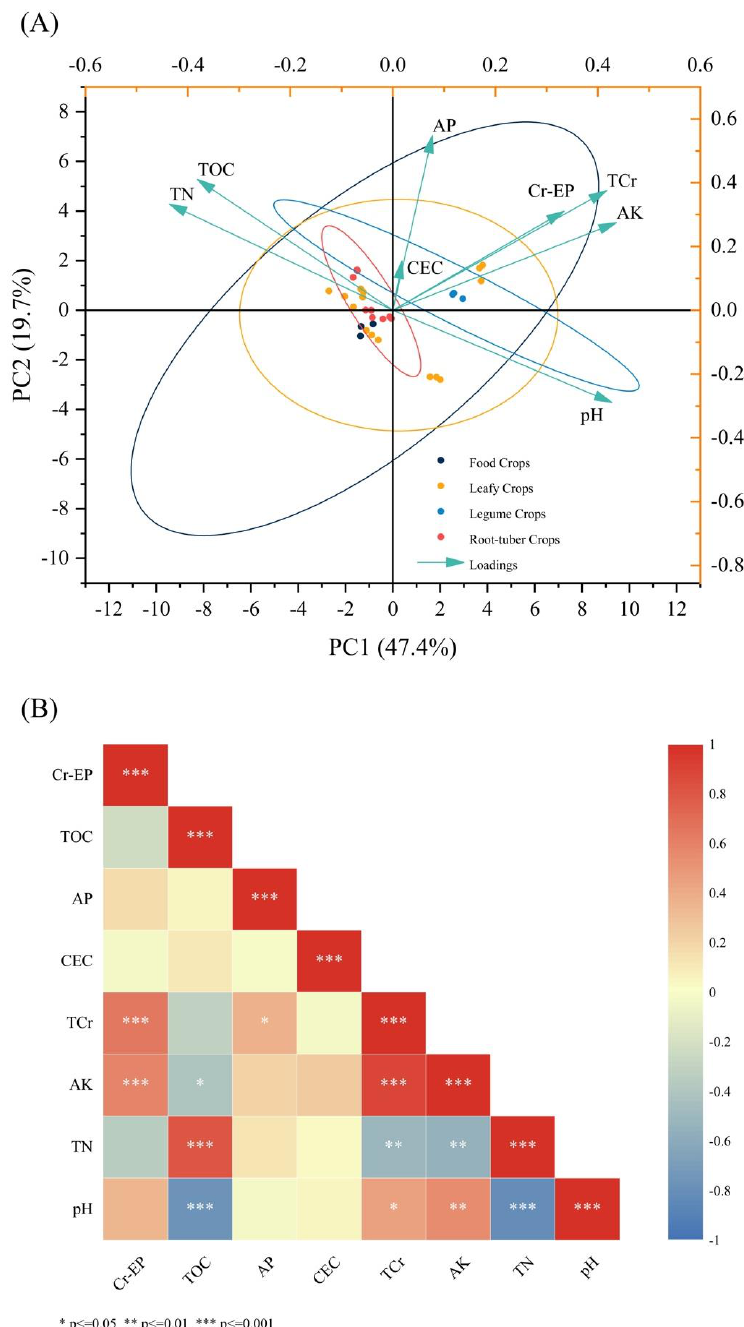
Figure 2. Principal component analysis (PCA) ( A ) and correlation analysis ( B ) for soil basic physi- cochemical properties, total Cr in soil, Cr bioaccumulation in the edible part of different crops. TCr: Total Cr in soil, Cr-EP: Cr in the edible part.